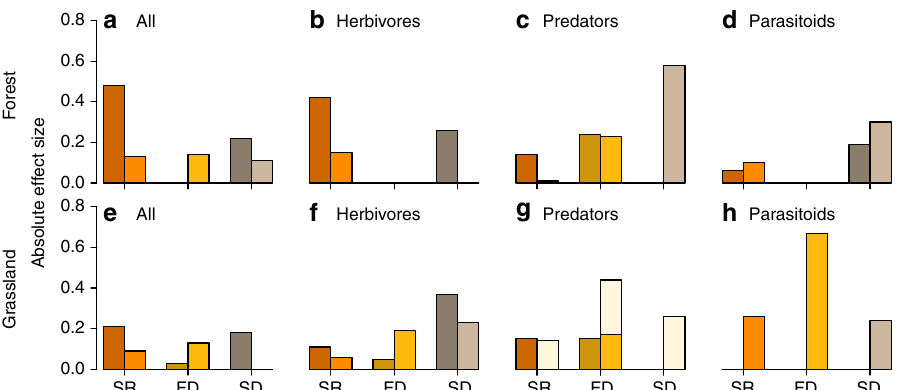
Fig. 3 Direct and indirect effects of plant diversity on arthropod species richness. Bars show summed effects of plant taxonomic (SR, orange color), functional (FD, yellow color), and structural (SD, brown color) diversity on arthropod species richness, obtained from the path models in Figs. 1 and 2. Absolute values are shown to enable better comparison of effect sizes among predictors. Effects are either direct (darker hues, left bar of each diversity component, connecting arthropod richness with plant diversity via direct paths) or indirect via arthropod abundance (lighter hues, right bar of each diversity component, effects of plant diversity on arthropod abundance, which in turn affected arthropod species richness). a – d show results for the forest experiment, e – h for the grassland experiment, with a , e featuring overall arthropod species richness, b , f herbivores, c , g predators, and d , h parasitoids. beige-colored bars in g show indirect effects of plant diversity on grassland predator species richness when restricting the analyses to arthropods directly sampled from the vegetation (i.e., excluding data from pitfall traps). Absolute effect size was calculated as the product of standardized path coef fi cients connecting each plant diversity component with arthropod species richness, summed over the individual predictors of each component (i.e., trait composition 1 + trait composition 2 + functional diversity for FD and horizontal structural variability + vertical structural strati fi cation for SD). Note that direct and indirect effects of plant species richness (SR) on arthropod richness also include the effects via FD and SD (because SR in fl uenced FD and SD, and effects of FD and SD on arthropod richness are therefore partial effects of SR). Source data are provided as a Source Data fi